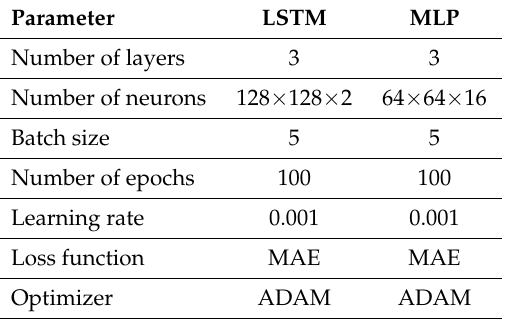
Figure 9. Training data: temperature and load data for July from 2009 to 2011. Table 1. Network parameters for